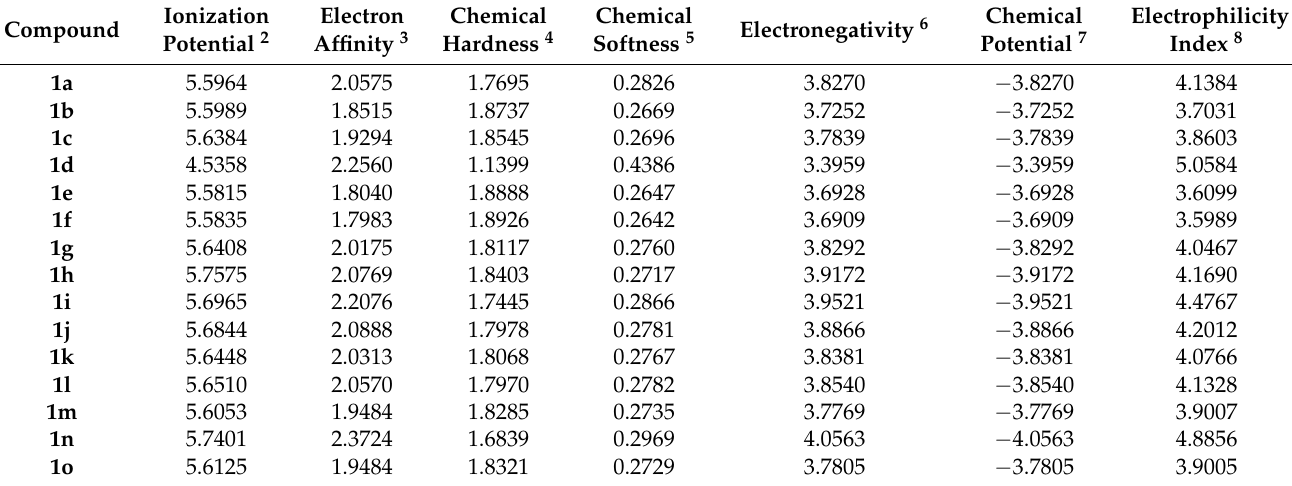
Table 3. Molecular descriptors calculated based on data generated by Spartan 14